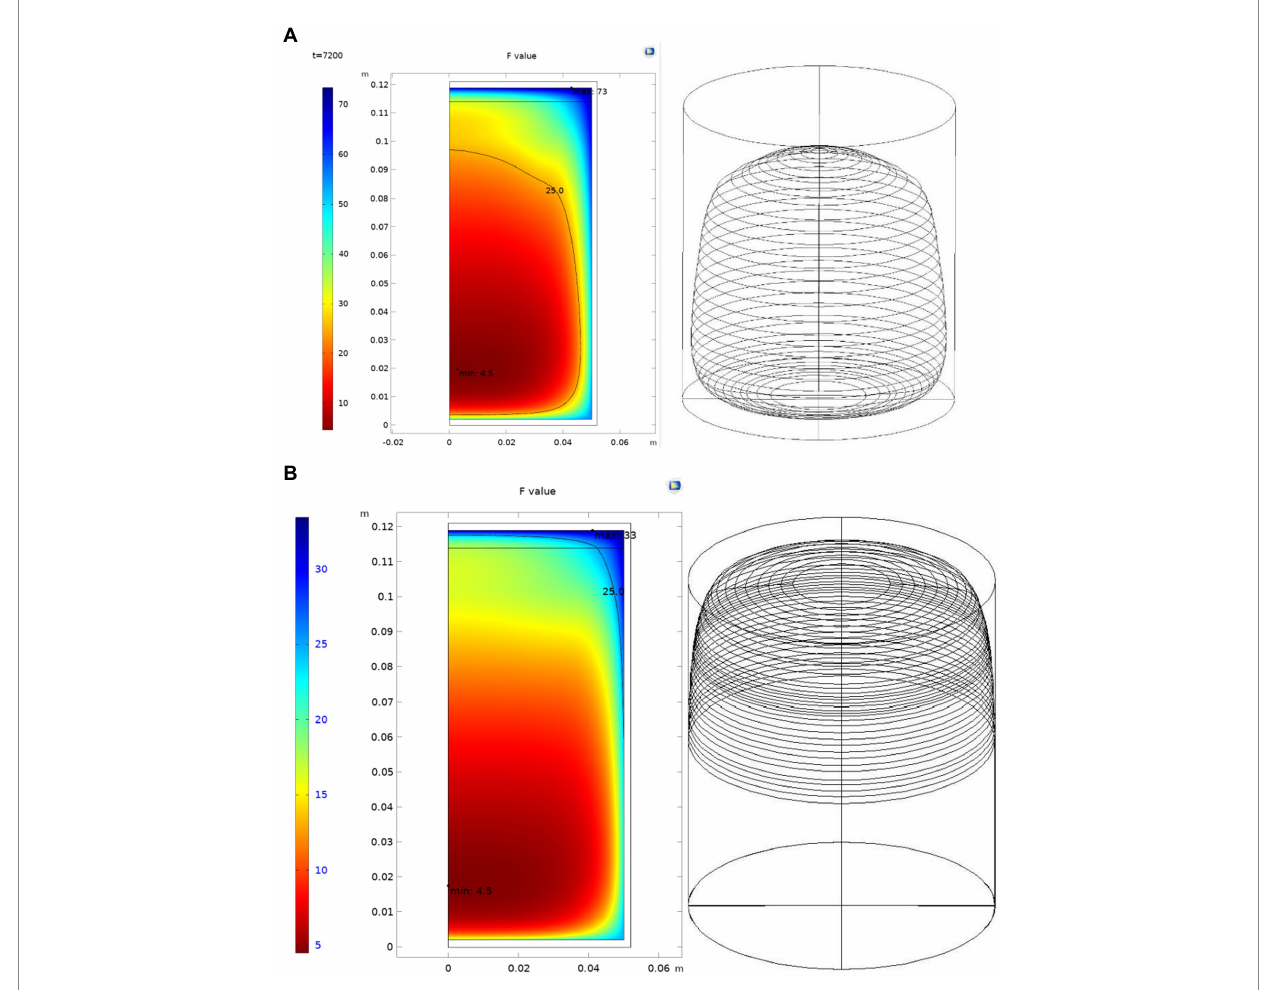
FIGURE. 7 Areas of F value within 25 before and after process adjustments. (A) Before process adjustment. (B) After process